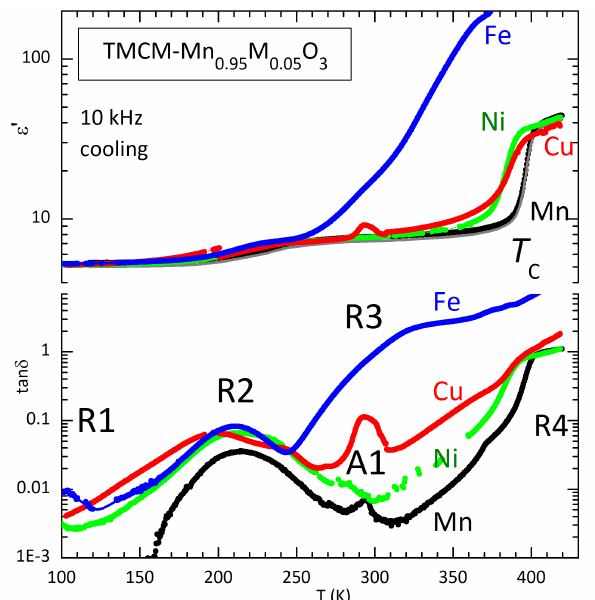
Figure 3. Dielectric permittivity of TMCM-Mn 0.95 M 0.05 Cl 3 measured during cooling at 10 kHz. The labels R n indicate thermally activated dielectric relaxations, while A n indicate anomalies of other